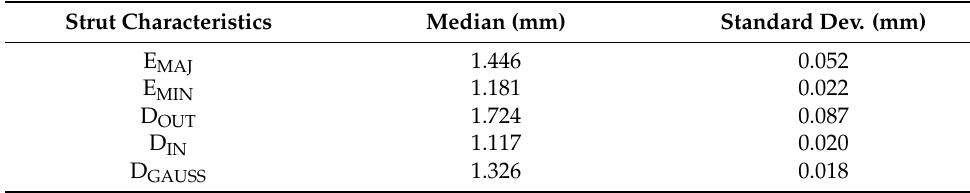
Table 4. Median values and standard deviation for strut characteristics of structure #6. Strut